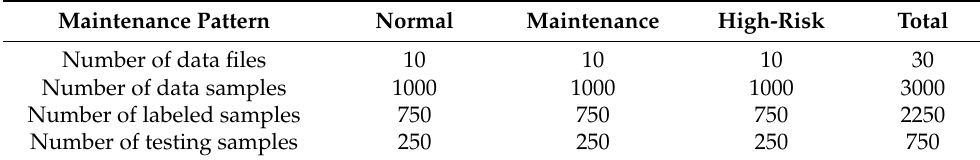
Table 1. Data sets